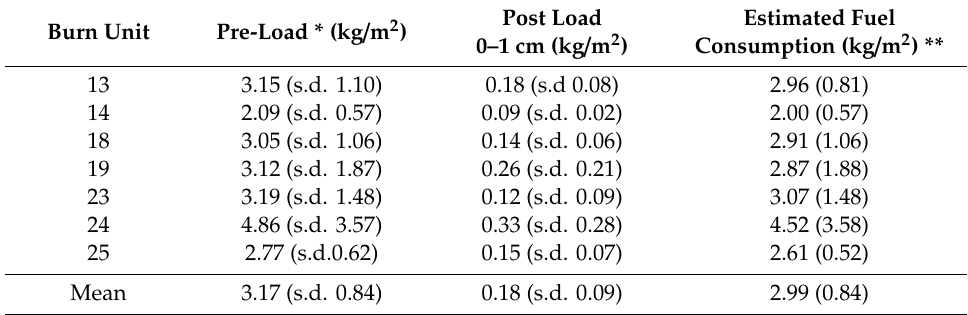
Table A4. Fuel consumption for Paquette Lake Summer 2017 burn units (n = 5 / burn unit).